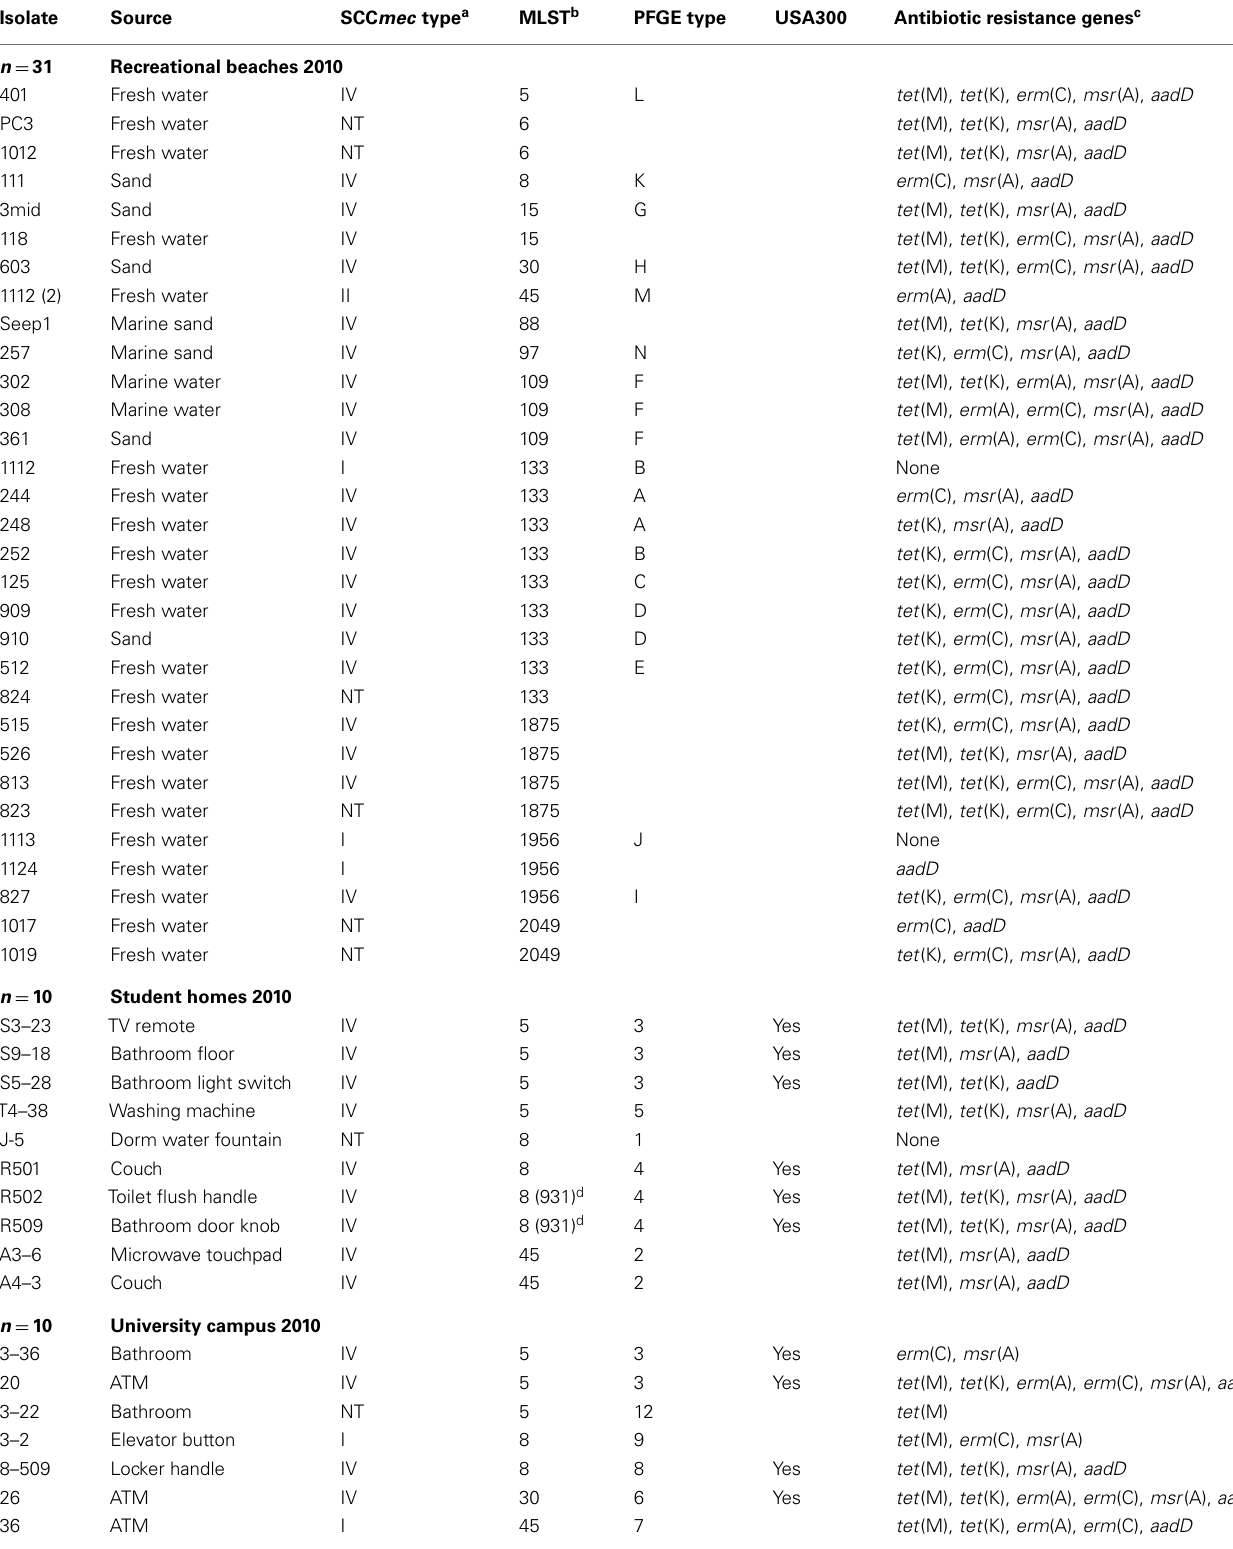
Table 1 | Genotypic characteristics of MRSA isolates from recreational beaches and built environmental high touch